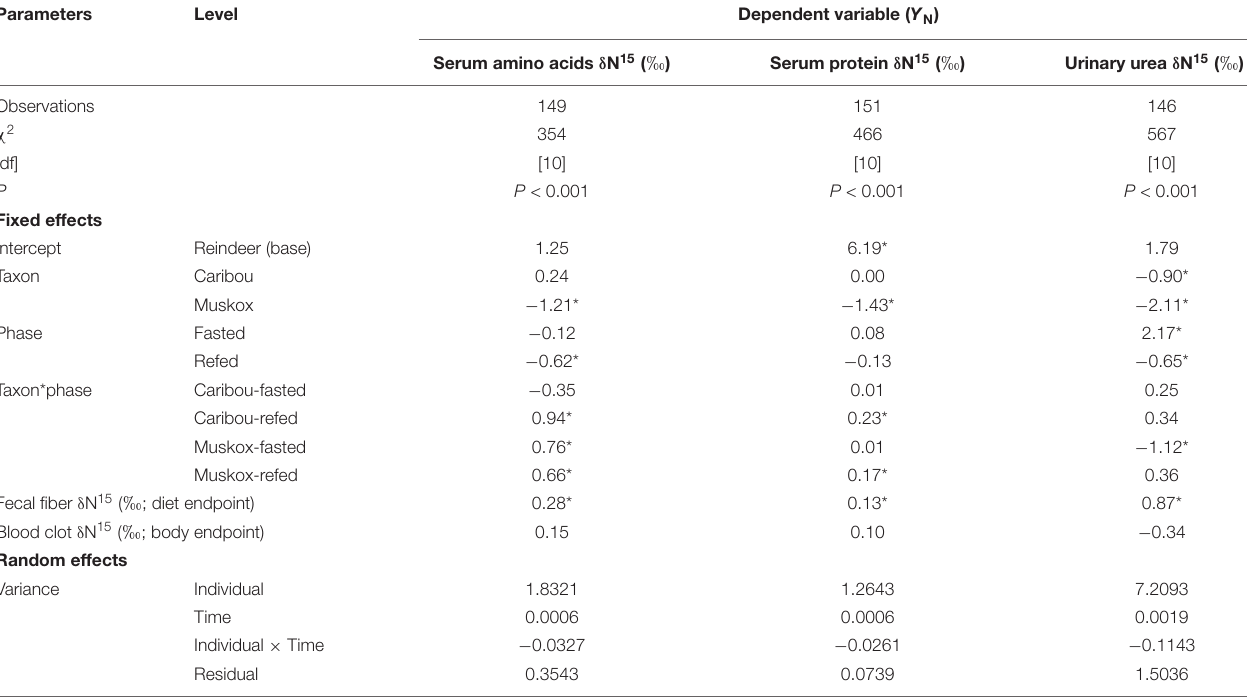
TABLE 3 | Results of mixed model regression for evaluation of body N pools ( Y N ) in female reindeer, caribou, and muskoxen from February to April 2009 in Fairbanks, AK, United States.